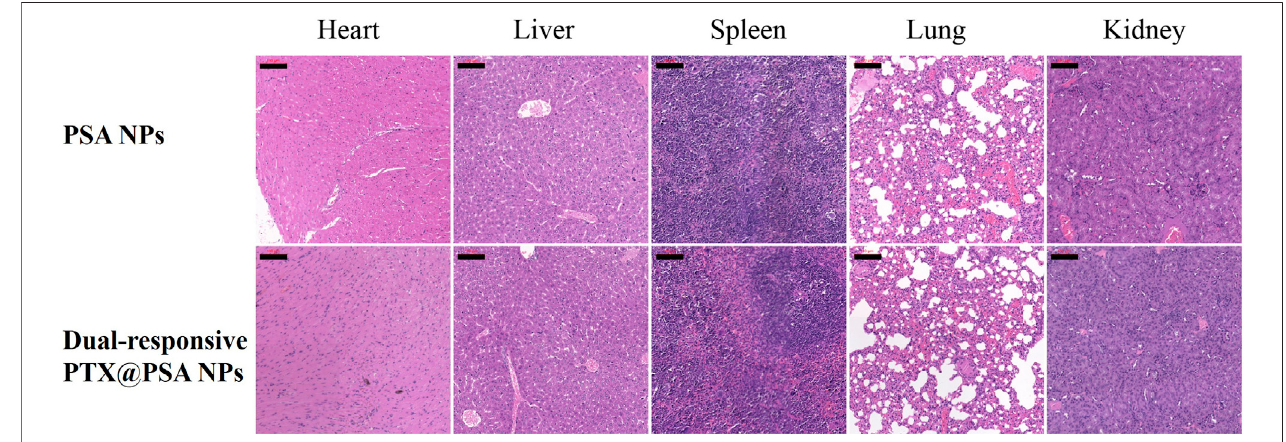
FIGURE 7 | The cytotoxic effect caused by PSA NPs and PTX@PSA NPs in major organs via H&E staining (heart, liver, spleen, lungs, and kidneys). Scale bars: 100 μ